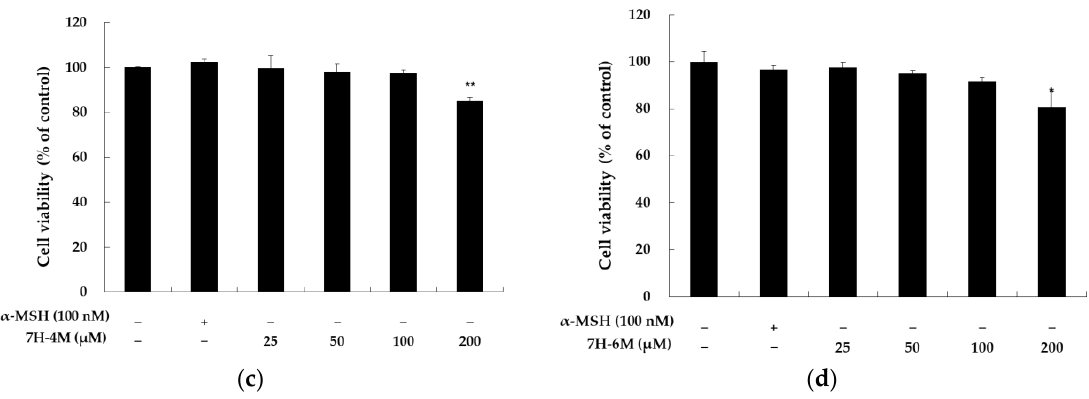
Figure 2. The effect of 7H-5,6DM ( a ), 7H-6,8DM ( b ), 7H-4M ( c ), and 7H-6M ( d ) on the viability of B16-F10 melanoma cells. The cells were plated in 24-well plates (8 × 10 3 cells/well), incubated for 24 h, and treated with 7H-5,6DM (25, 50, 100, and 200 µM), 7H-6,8DM (25, 50, 100, and 200 µM), 7H-4M (25, 50, 100, and 200 µM), 7H- 6M (25, 50, 100, and 200 μM), and α -MSH (100 nM) for 72 h. The cytotoxicity of 7H-5,6DM, 7H-6,8DM, 7H-4M, and 7H-6M was evaluated using MTT assays. The results are presented as the mean ± SD of independent experiments. * p < 0.05, ** p < 0.01, *** p < 0.001 vs. the unstimulated control group.